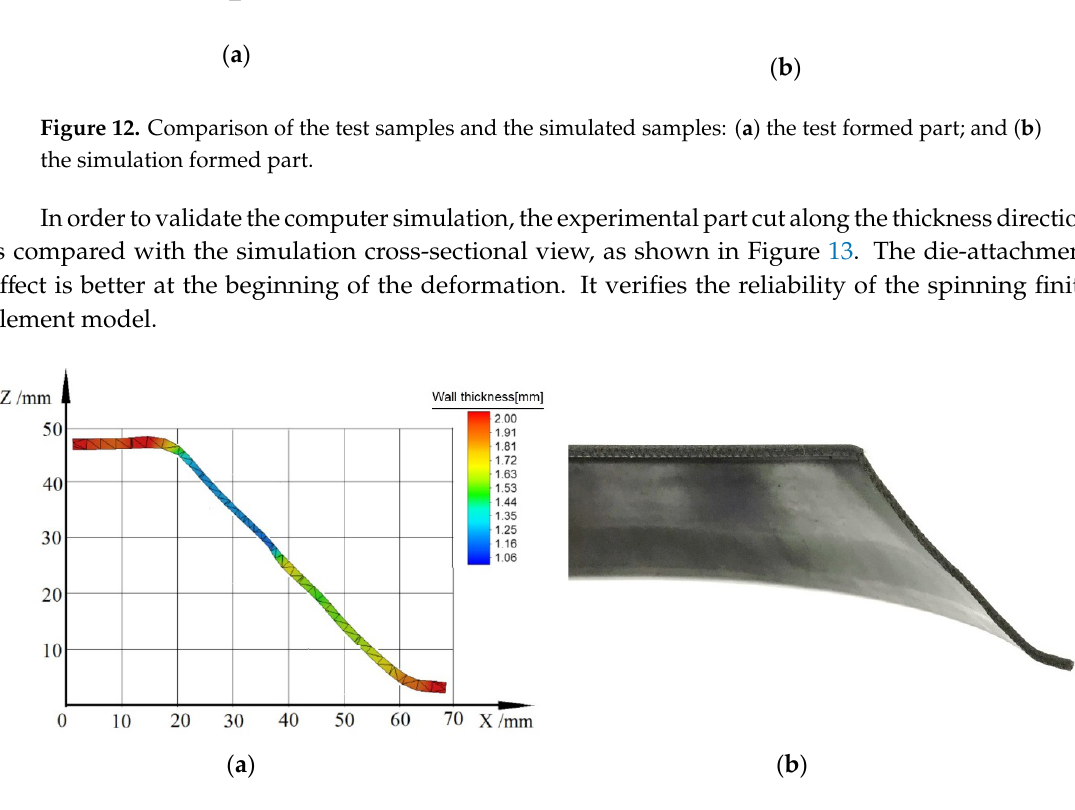
Figure 13. Comparison of wall thickness: ( a ) simulation cross-sectional part; and ( b ) cross-section of the experimental part.